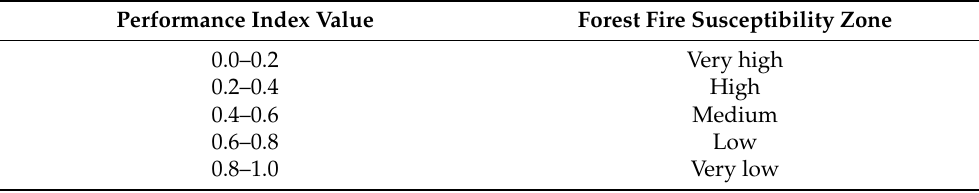
Table 2. Forest fire susceptibility zones classification according to performance index values.